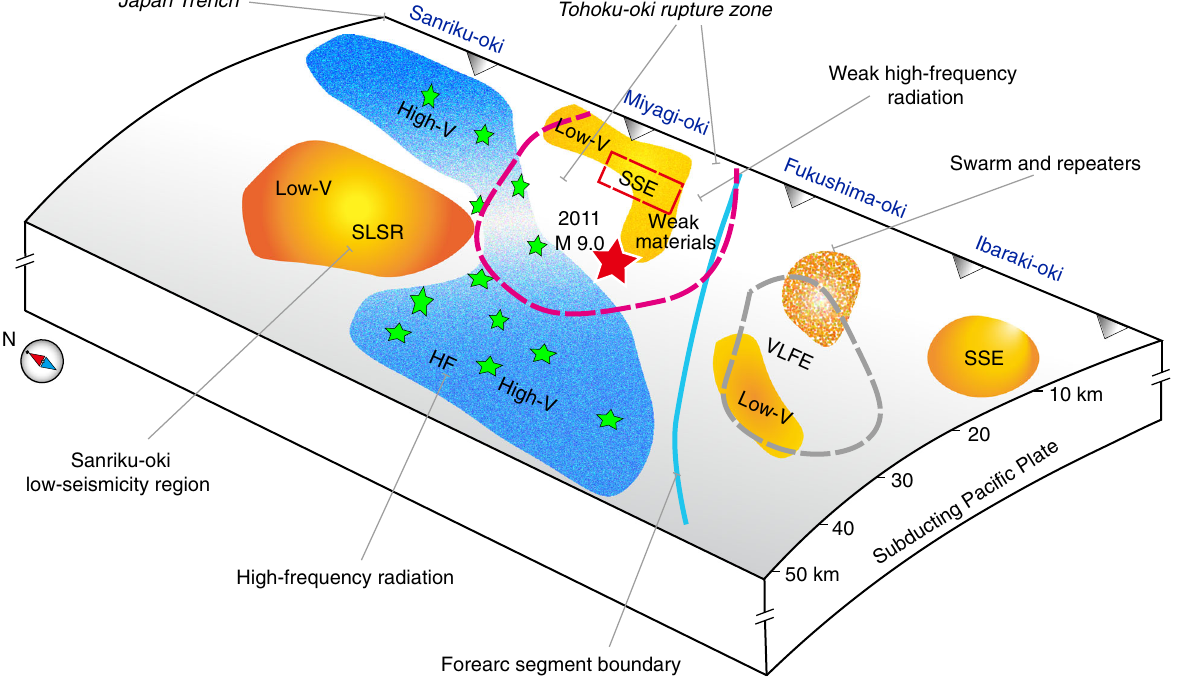
Fig. 3 A schematic diagram of structural heterogeneities in the Tohoku megathrust zone. The red star denotes the mainshock epicenter of the great 2011 Tohoku-oki earthquake (Mw 9.0). The green stars represent epicenters of other megathrust earthquakes (M ≥ 7.0). The red dashed line denotes the range of main shock rupture zone of the 2011 Tohoku-oki earthquake. The gray dashed line denotes the area where very low frequency earthquakes (VLLF) occurred. The blue line denotes the forearc segment boundary 21 . SSE, slow slip events. The slab geometry and shape of the Japan trench are simpli fi